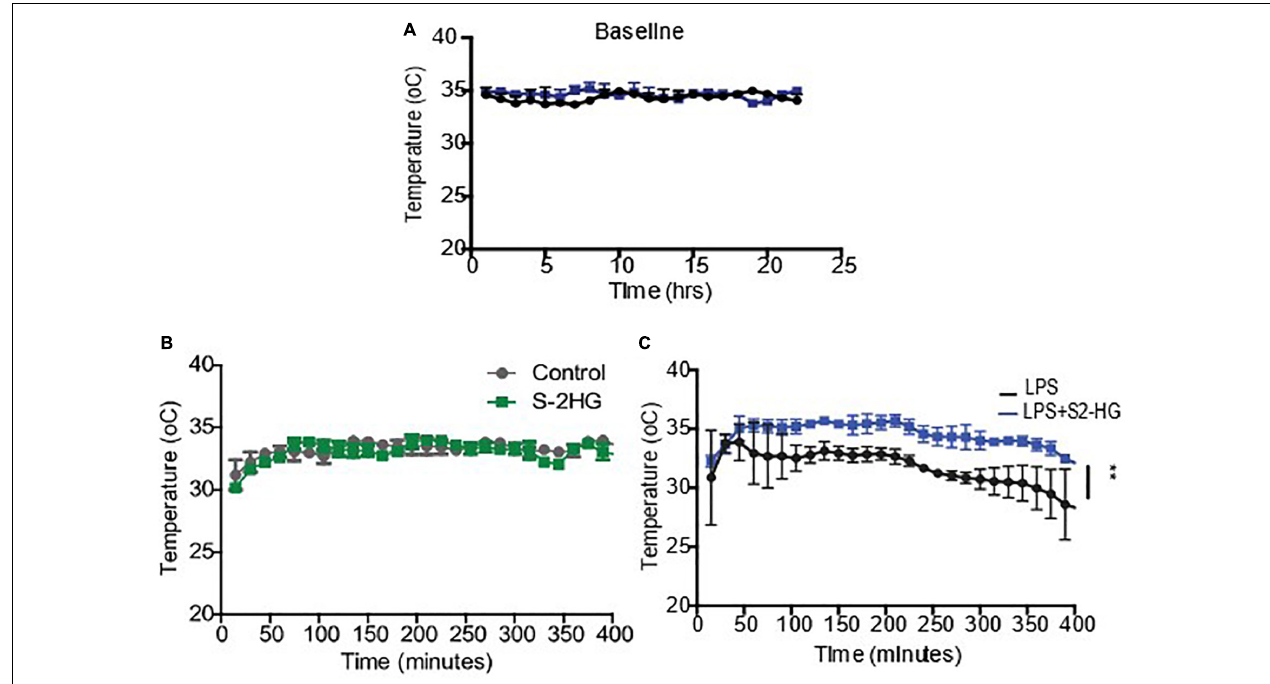
FIGURE 2 | 2-HG protects against LPS induced hypothermia. Mice were surgically implanted with a radiotelemetry probe. 10 days post-surgery (A) Baseline temperature recordings were obtained. Mice were subsequently treated (B) S-2-HG (50 ug/kg) (C) LPS (15 mg/kg) or a combination of LPS and S-2HG and temperature recordings were obtained for an additional 8 h. N = 4/5. * p <